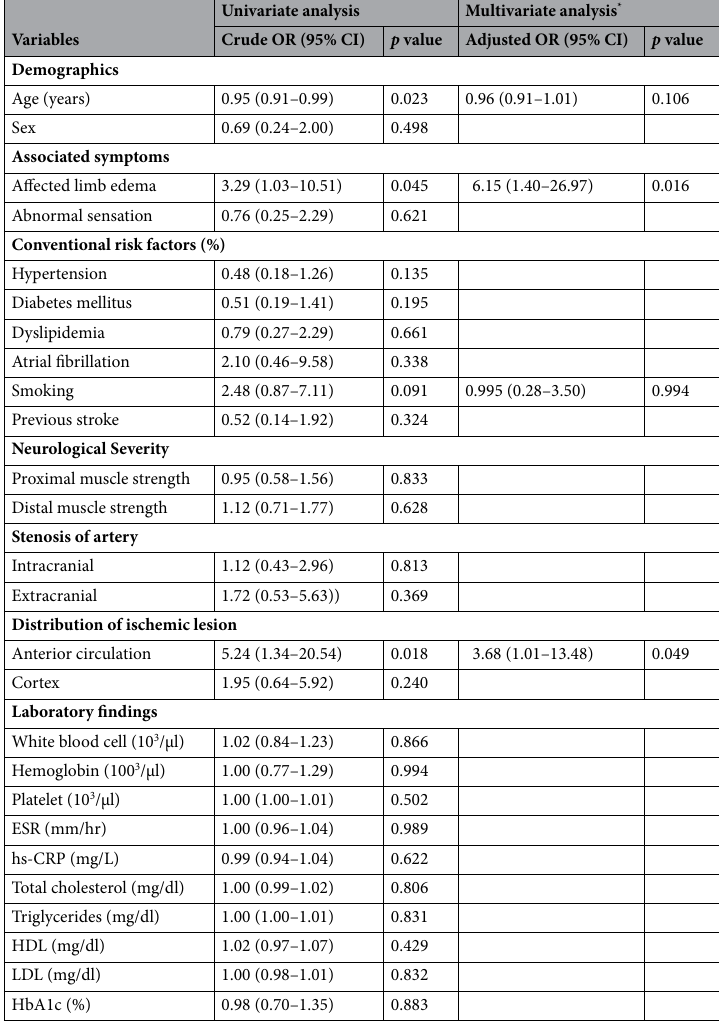
Table 3. Logistic regression analysis according to Raynaud scan results. OR odds ratio, CI confidence interval, ESR erythrocyte sedimentation rate, hs-CRP high sensitivity C-reactive protein, HDL high density lipoprotein, LDL low density lipoprotein, HbA1c hemoglobin A1c. * Adjusted for age, smoking, affected limb edema, anterior circulation, and